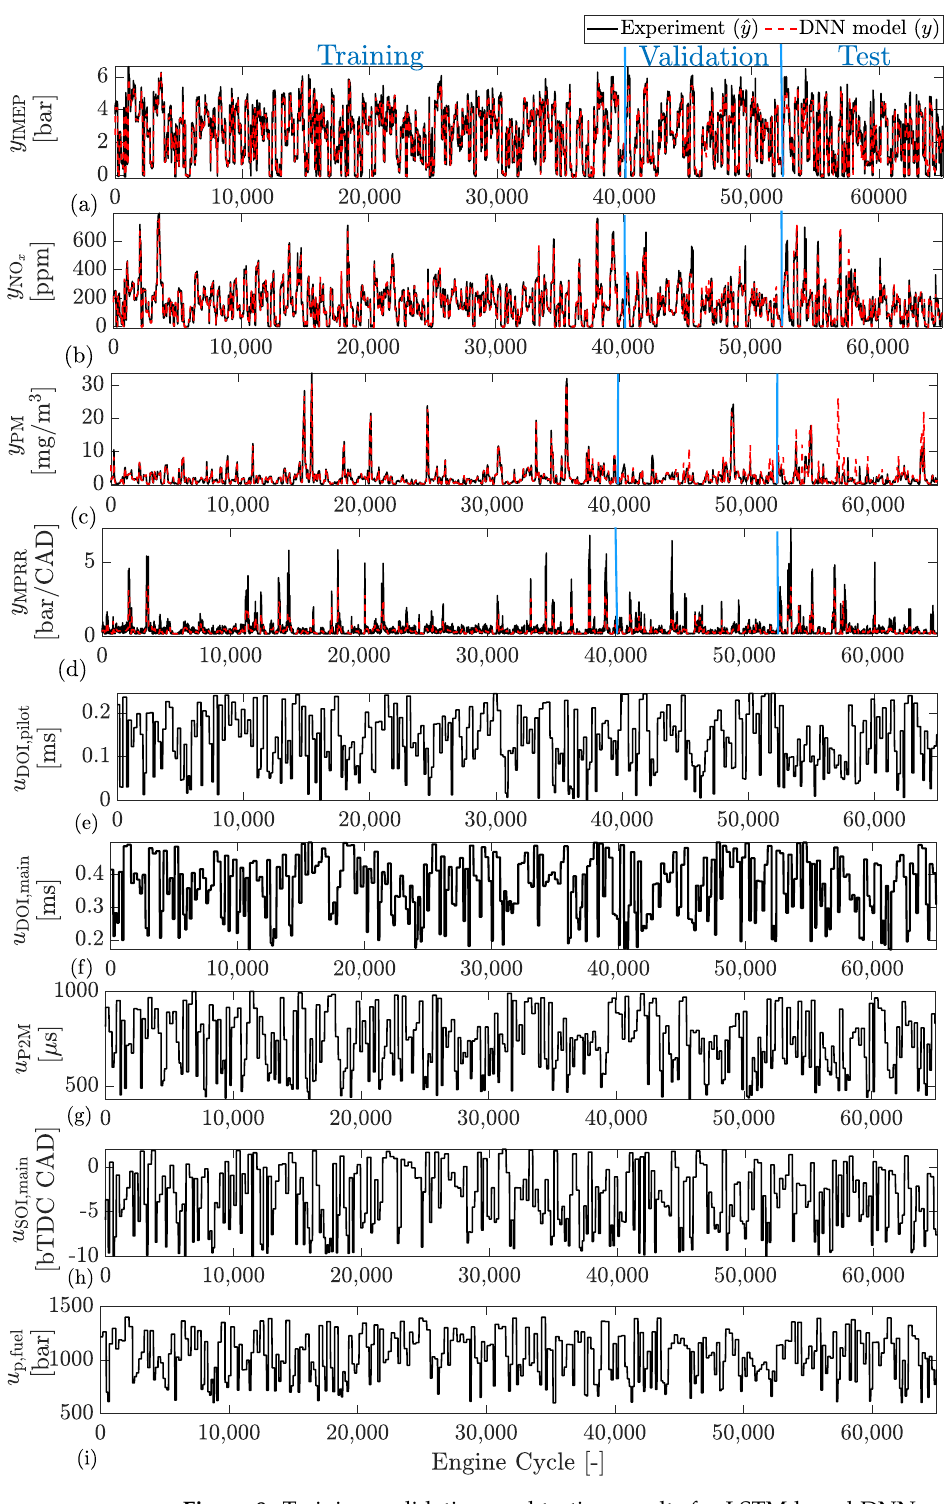
Figure 8. Training, validation, and testing results for LSTM-based DNN model vs. experimental data—( a ) y IMEP —indicated mean effective pressure (IMEP), ( b ) y NO (NO x ), ( c ) y PM —Particle Matter (PM), ( d ) y MPRR —maximum pressure rise rate